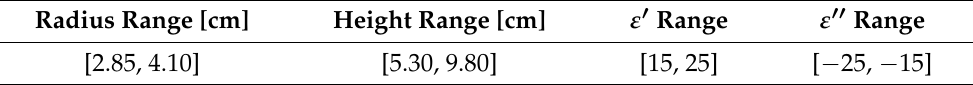
Table 1. Summary of fibroglandular region variations in the labelled dataset.